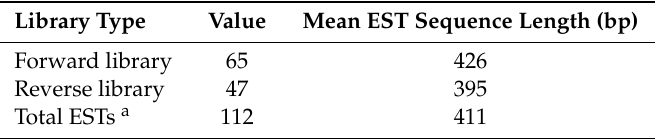
Figure 2. Screening and identification of differential expressed sequence tags (ESTs) from the Nosema ceranae infected honey bee by suppression subtractive hybridization (SSH) and Dot-blotting. ESTs insert size of ( A ) forward and ( D ) reverse SSH complementary DNA (cDNA) libraries were confirmed by colony PCR. ( B ) Forward subtractive library (fsl, differential ESTs in infected group) hybridized with forward-subtracted probe and ( C ) with reverse-subtracted probe. ( E ) Reverse subtractive library (rsl, differential ESTs in control group) hybridized with reverse-subtracted probe and ( F ) with forward-subtracted probe. M = 100 bp DNA ladder. The arrows indicated the differential ESTs for sequencing. Table 1. Information for the expression sequence tags